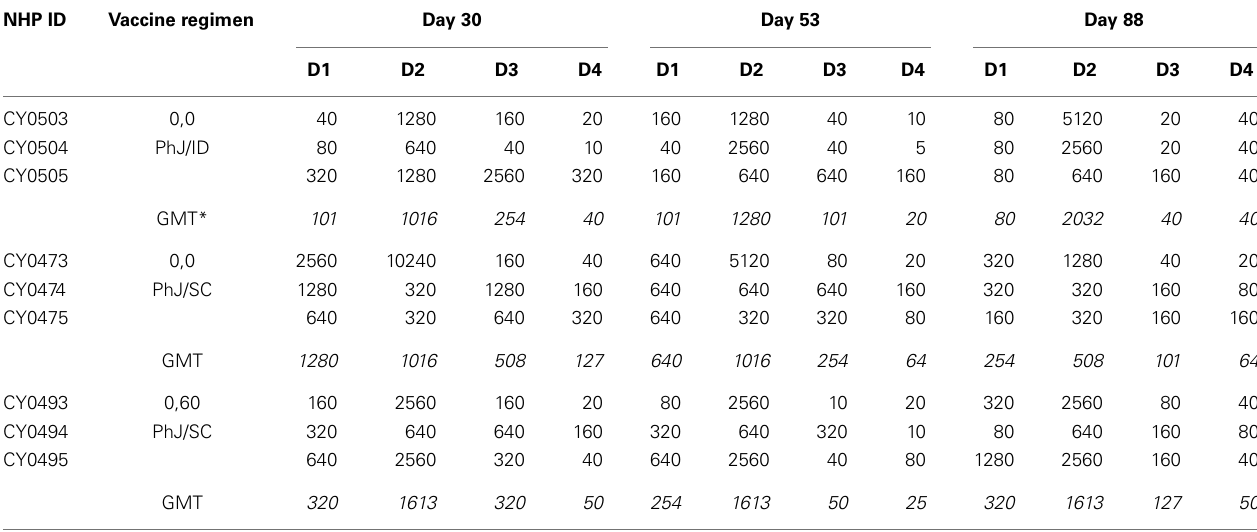
Table 4 | Kinetics of neutralizing antibody responses in animals vaccinated withTDV SC or ID using the PharmaJet device . NHP ID Vaccine